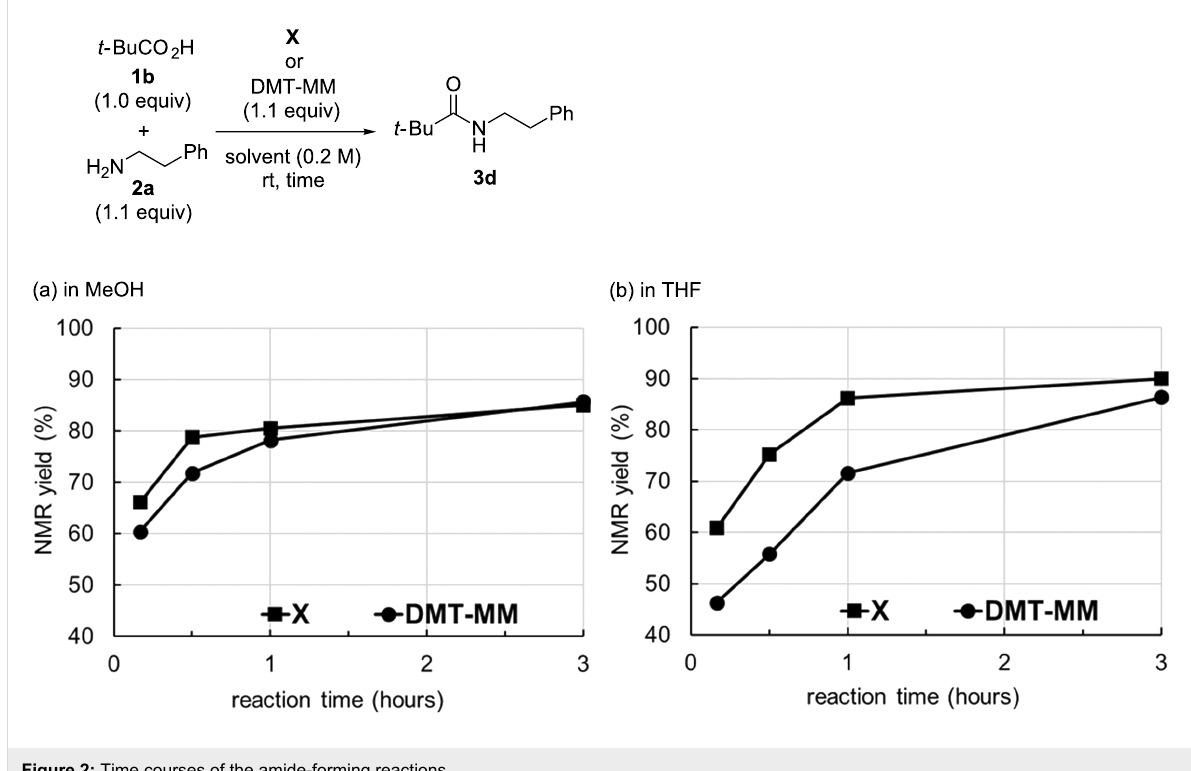
Figure 2: Time courses of the amide-forming reactions.